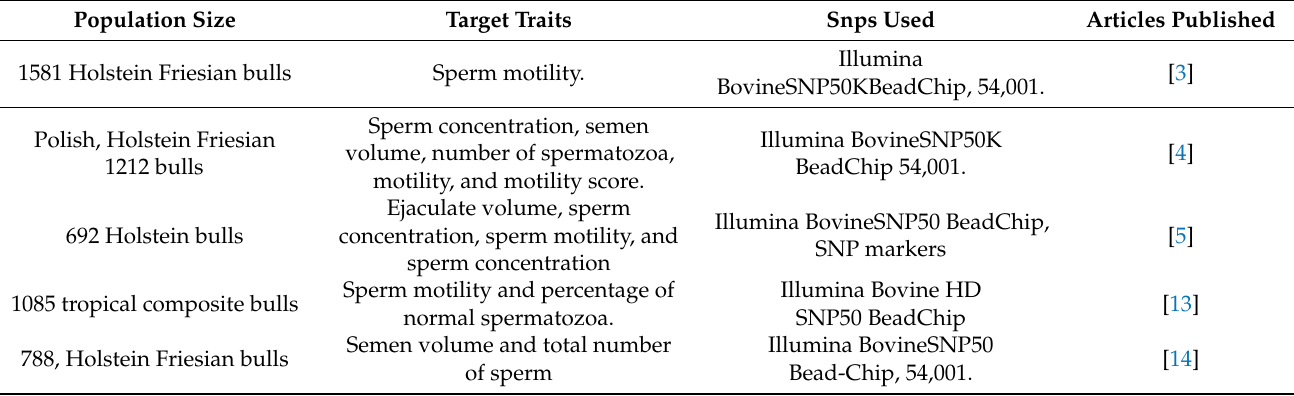
Table 1. Studies conducted using Illumina on semen traits. Population Size.